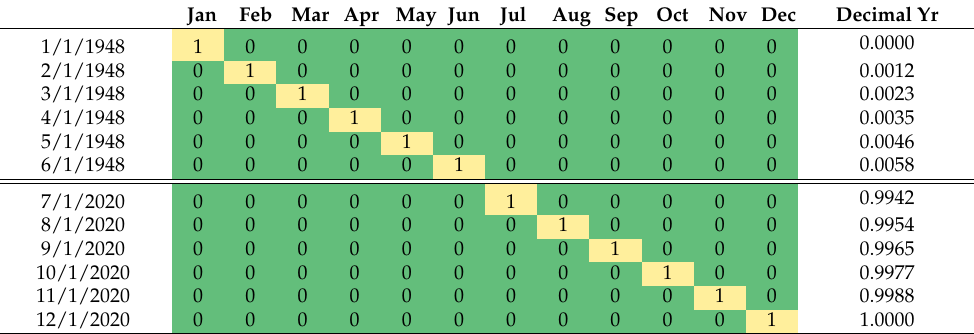
Table 1. Example of the time features; this includes one-hot encoding of the monthly data (green and yellow squares) and the linear time feature in the right-most